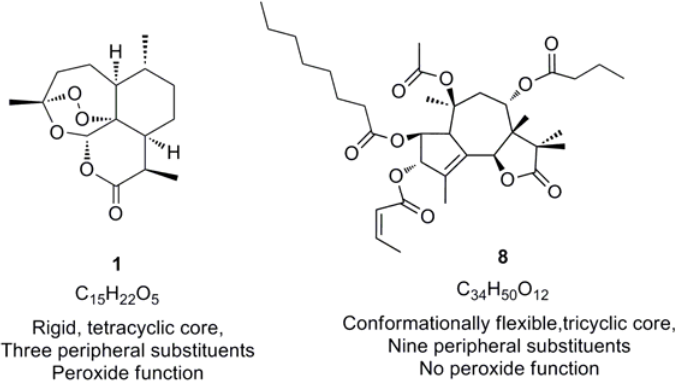
Figure 7. Comparison of the structural and chemical features of sequiterpene lactones artemisinin ( 1 ) and thapsigargin ( 8 )